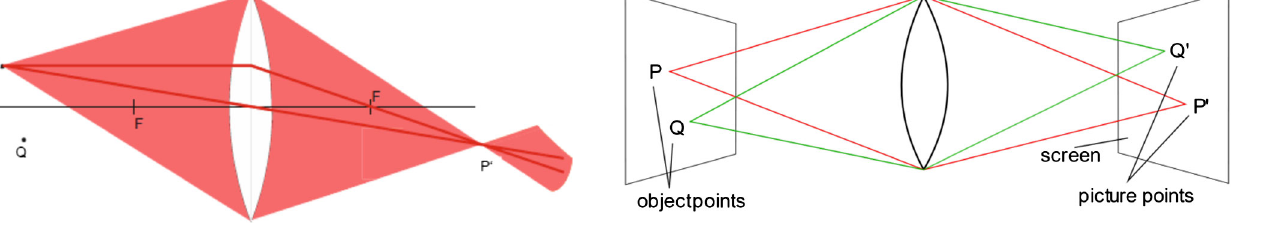
FIG. 7. The propagation of light from a pointlike light source represented by light rays and diverging light beams.